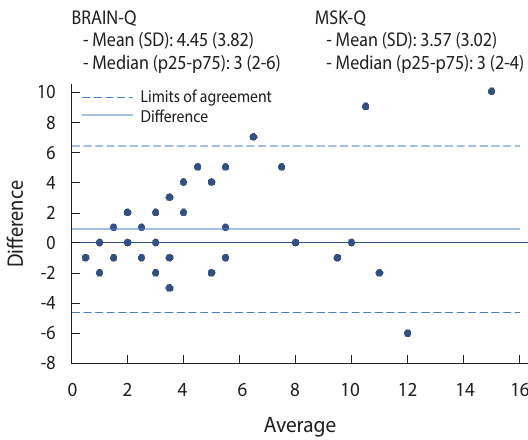
Figure 2. Bland-Altman plot – y-axis shows difference between the two concussion measures (BRAIN-Q and MSK study-main) and x- axis shows average number of any concussion among 53 partici- pants. BRAIN, BRain health and healthy AgeINg in retired rugby un- ion players; BRAIN-Q, BRAIN questionnaire tool; MSK study, Oxford and Cambridge University players and English international rugby players; MSK-Q, muscle skeletal questionnaire; SD, standard devia- tion; p, percentile.